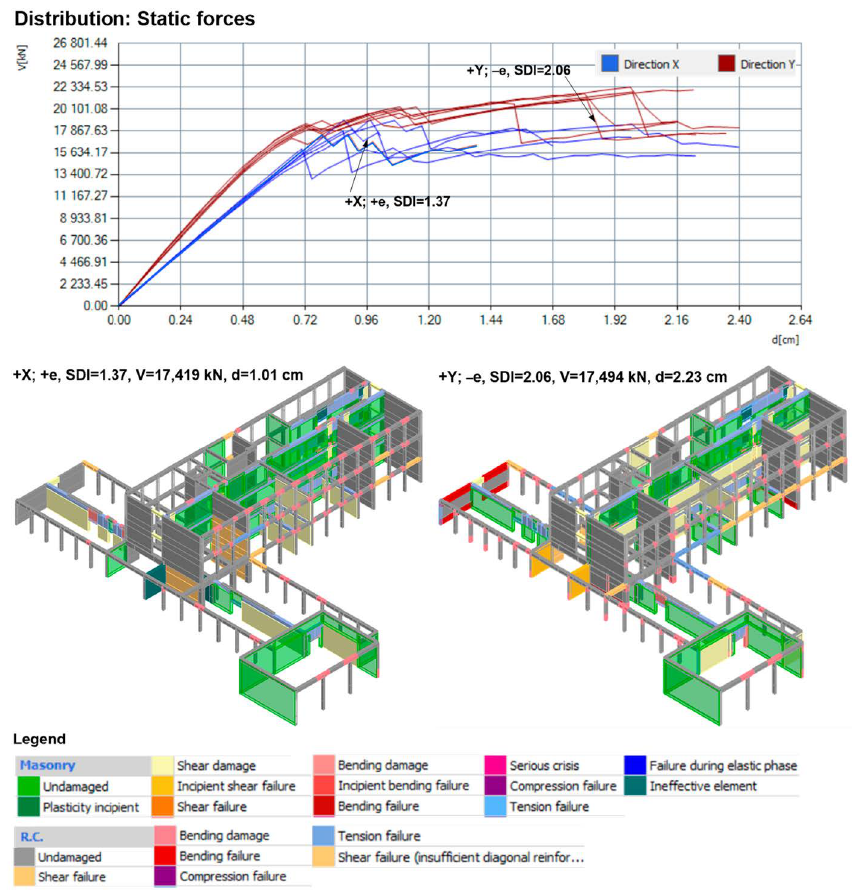
Figure 30. EFM results: pushover curves and corresponding damage mechanism of the retrofitted structure obtained using the static forces load pa tt ern.